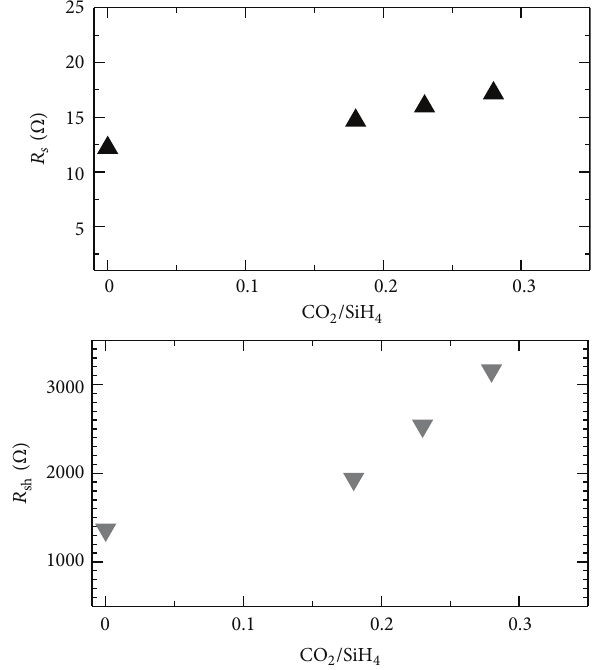
Figure 5: 𝑅 𝑠 and 𝑅 of a-SiO:H/ 𝜇 c-Si:H micromorph silicon solar sh cells using n top 𝜇 c-Si(O):H layer deposited with various CO 2 /SiH 2 ratios.